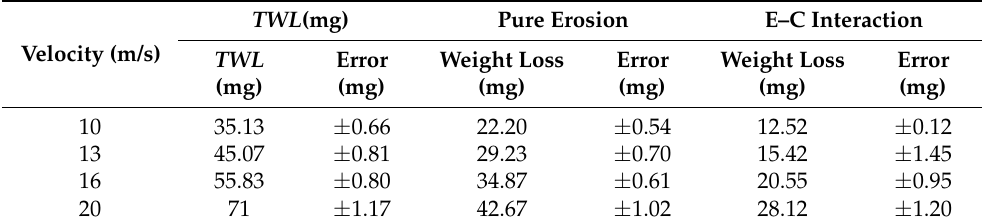
Figure 10. Effect of sand loading on weight loss at 20 m/s. Table 2. Weight loss due to velocity effect at 600 mg/L.